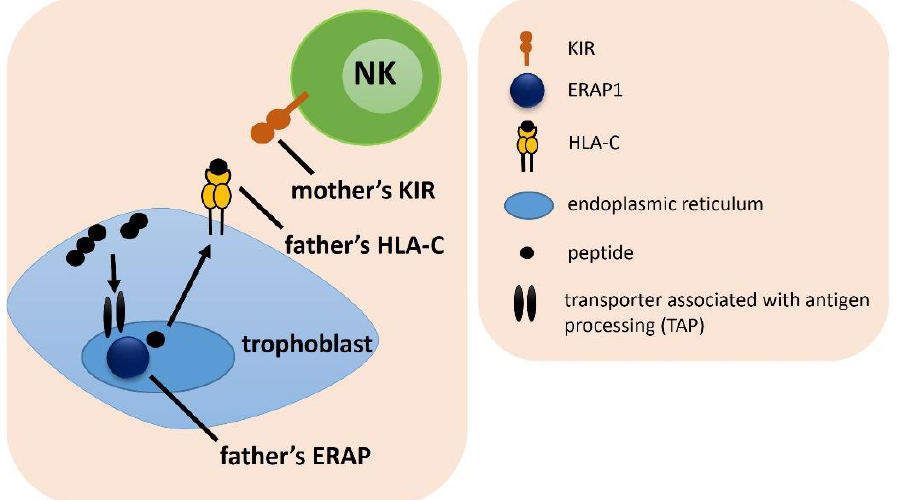
Figure 5 . The influence of female KIR with male HLA-C and ERAP on embryo implantation. The arrows indicate the successive stages of the formation of antigenic peptides.